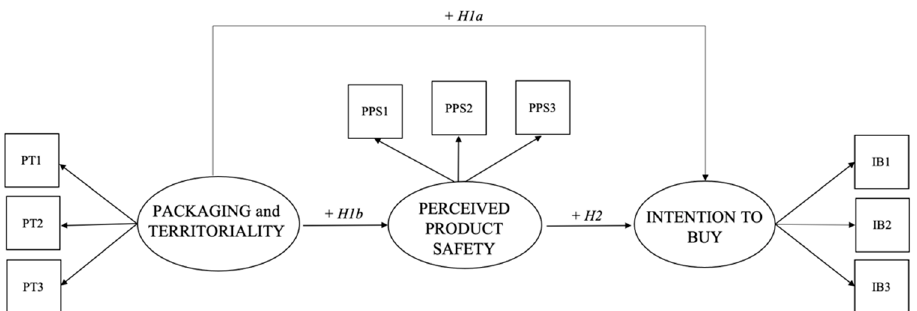
Figure 1. The hypothesized theoretical